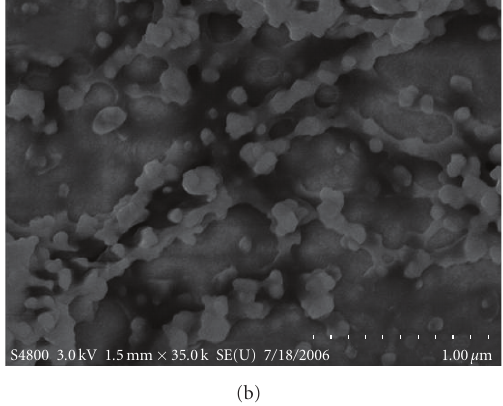
2.2. Instrument. The LbL assembly process was measured 53131A 225 MHz) and water contact angle